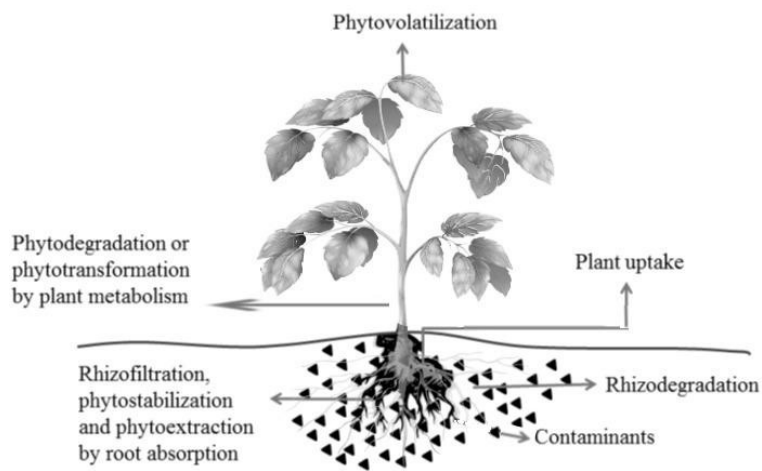
Fig. 1: Phytoremediation mechanism (Kamath et al., 2004)